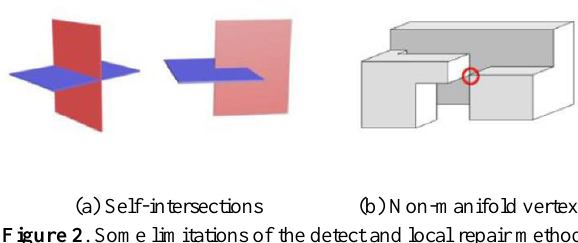
Figure 2 . Some limitations of the detect and local repair method (Alam et al., 2014).